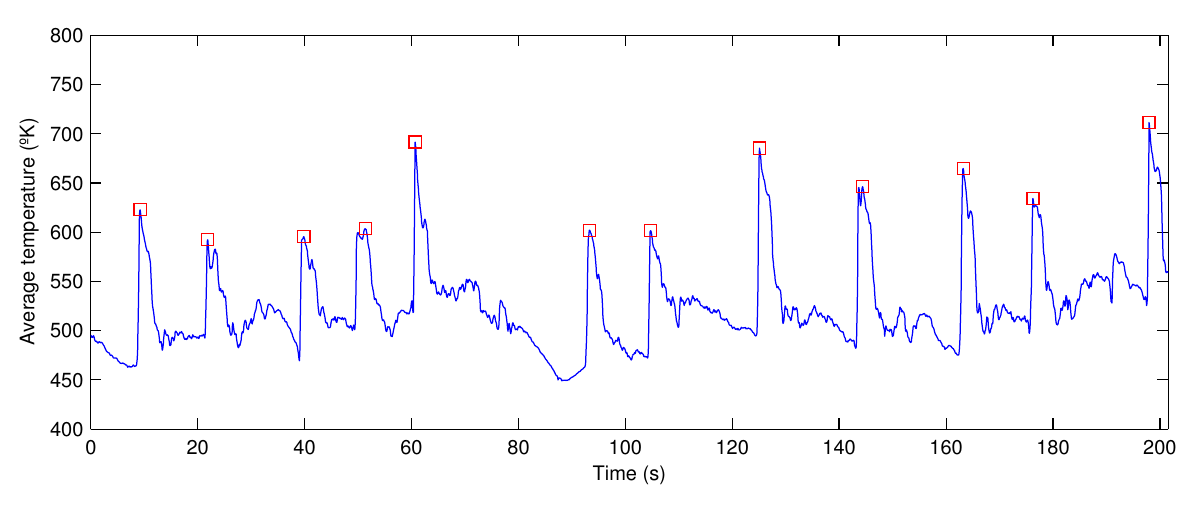
Figure 6. Average temperature per frame at 15 frames per